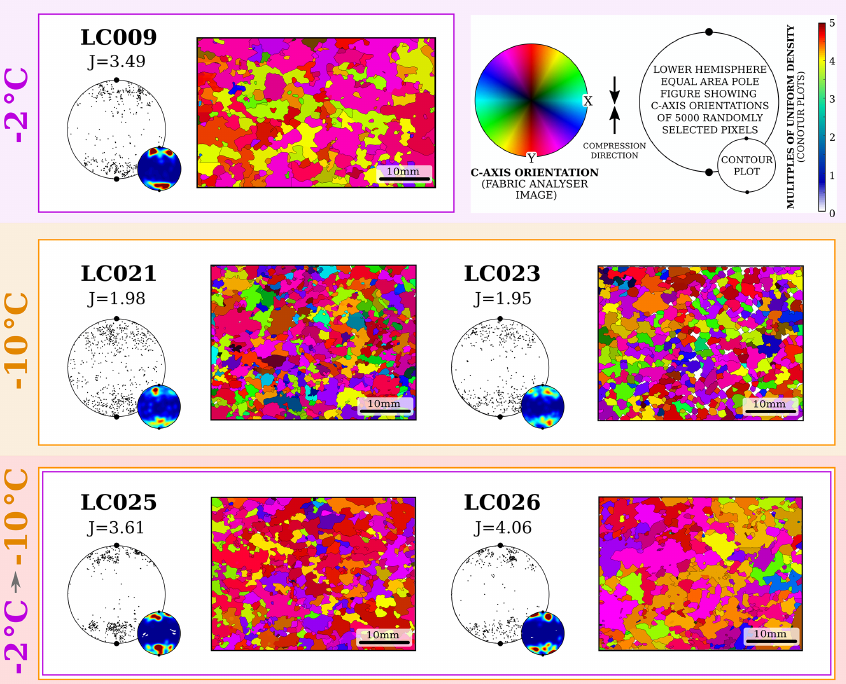
Figure 5. Results from microstructural analysis of all samples in set 2 ( − 2 to − 10 ◦ C). Shown for each sample, from left to right: sample number and J index above a lower-hemisphere stereonet plot of c -axis orientations of 5000 randomly selected pixels, alongside a contoured plot of the same data (scale shown in the upper right); thin section image from processed fabric analyser data, coloured by c -axis orientations according to the legend (upper